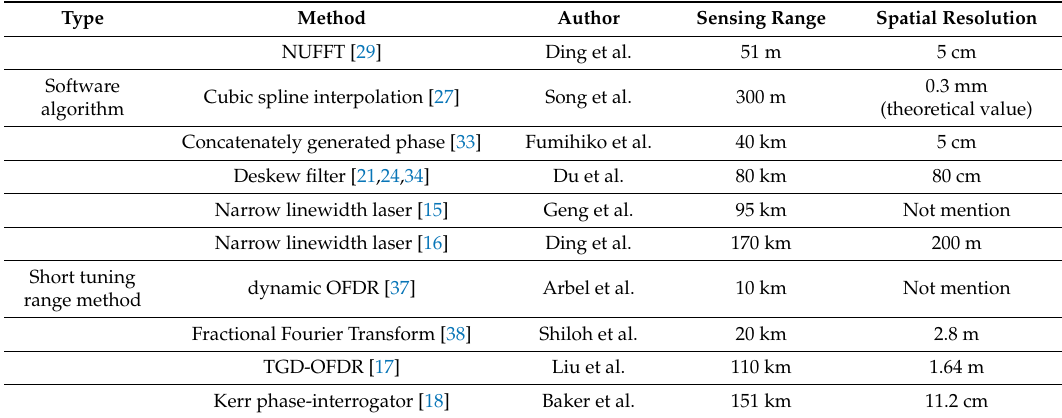
Table 1. Performance summary of software algorithms and short tuning range methods for compensation of the nonlinear phase noise in